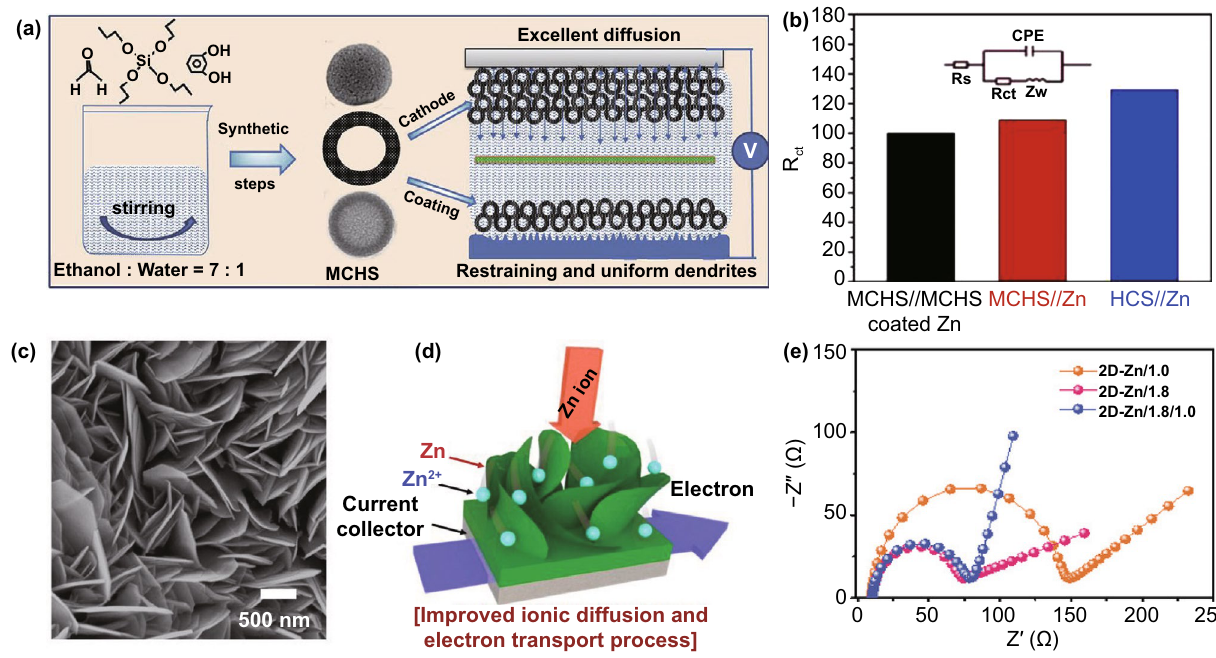
Fig. 2 a Schematic illustration of the synthesis process of MCHSs and corresponding application in electrodes of ZHSCs. b Comparison of R ct value for the three devices. Reproduced with permission from Ref. [92]. Copyright 2019, Elsevier. c SEM image and d schematic illustration of the hierarchically 2D‑Zn anode. e Nyquist plots of different 2D‑Zn anodes. Reproduced with permission from Ref. [53]. Copyright 2020, Wiley–